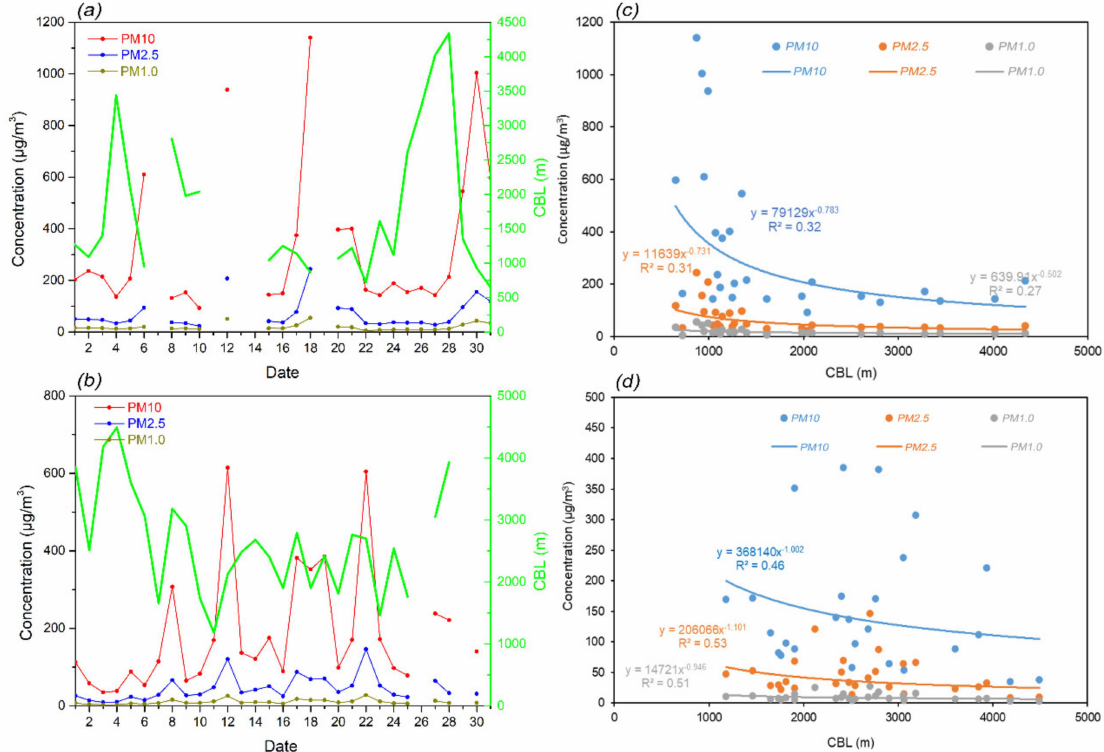
Figure 10. Temporal variations of PM 10 /PM 2.5 /PM 1.0 concentrations in the surface layer, and the ABLH in MF ( a ) and TZ ( b ); the relationships between PM concentration near-surface and ABLH in MF ( c ) and TZ ( d